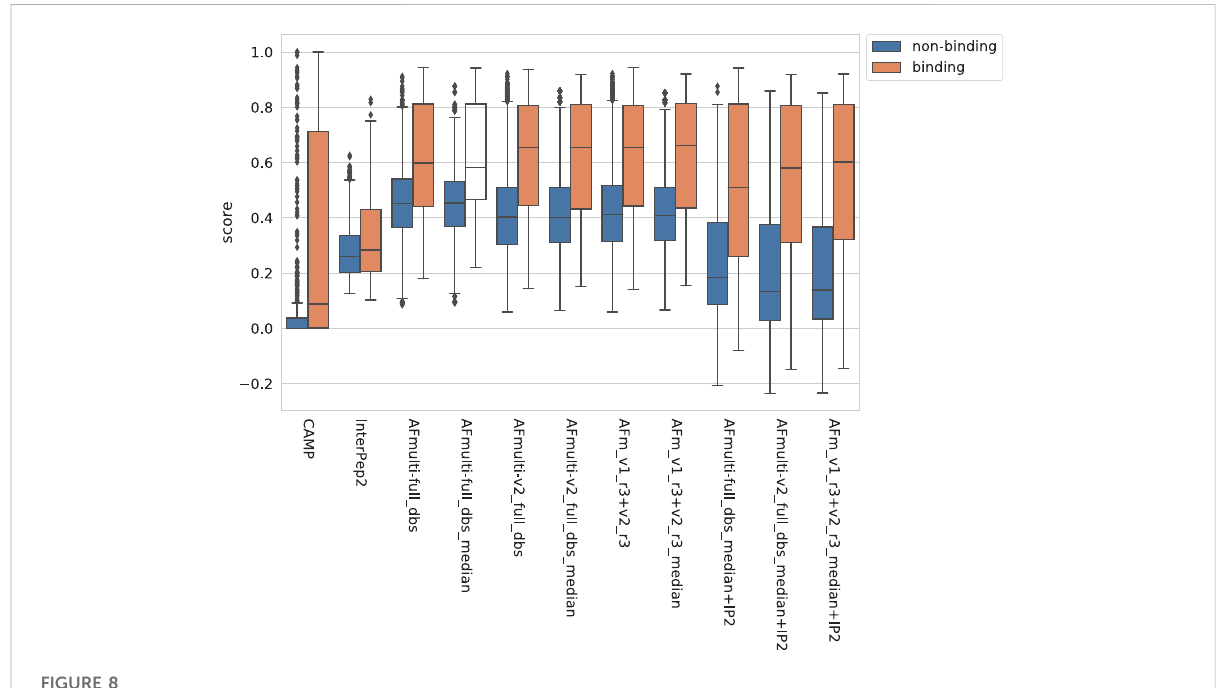
FIGURE 8 Distribution of scores reported by the method for non-binding and binding peptide-protein pairs, respectively, from different versions of AlphaFold, with CAMP and InterPep2 as reference previous methods.